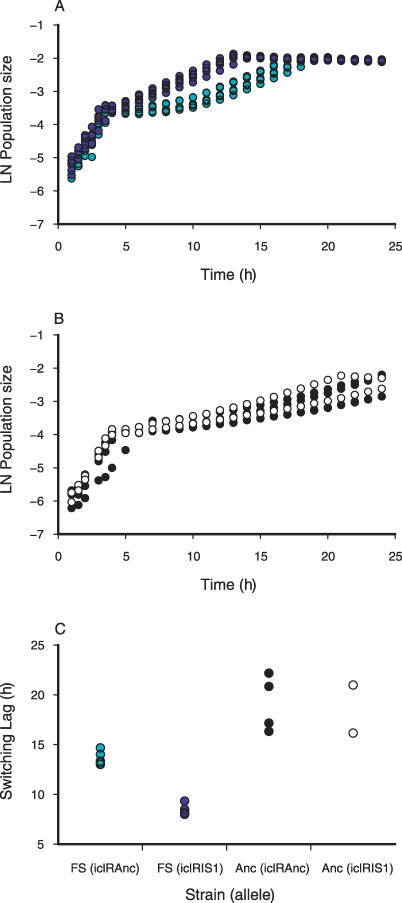
Growth Curves and Switching Lags for Genetically Derived StrainsThe iclRIS1 allele (dark blue) alters switching lag relative to the iclRAnc allele (light blue) in the genetic background of the FS ecotype (A and C) but not the ancestral genetic background with alleles shown in white and black, respectively (B and C; F3,12 = 32.0, p < 0.0001). Growth rates on glucose and acetate are not measurably affected by alleles at this locus (unpublished data; glucose: F3,12 = 28.0, p < 0.0001; acetate: F3,11 = 157.5, p < 0.0001).